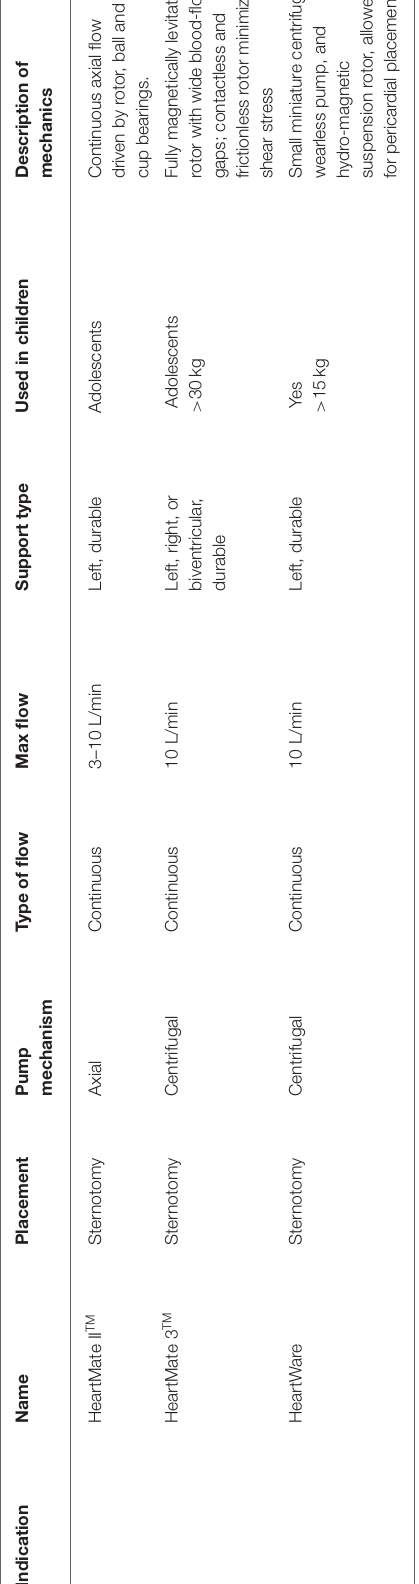
FIGURE 1 | Durable devices: (A) Heartware (B) Heartmate3 (C) Jarvik infant (D) Berlin Heart.